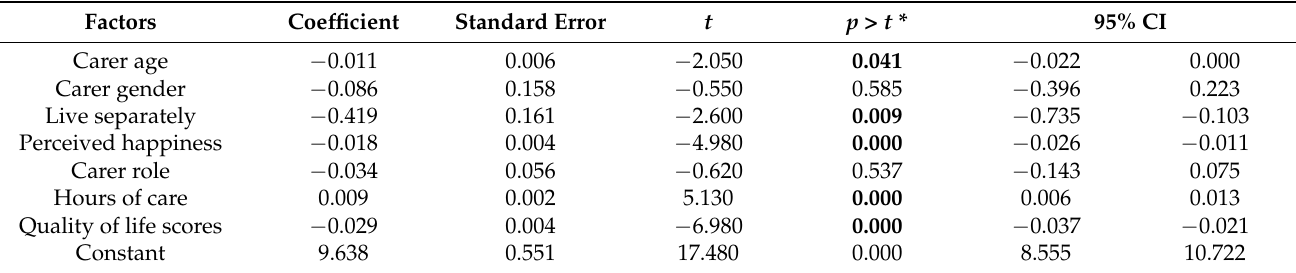
Table 4. Factors associated with loneliness levels in informal